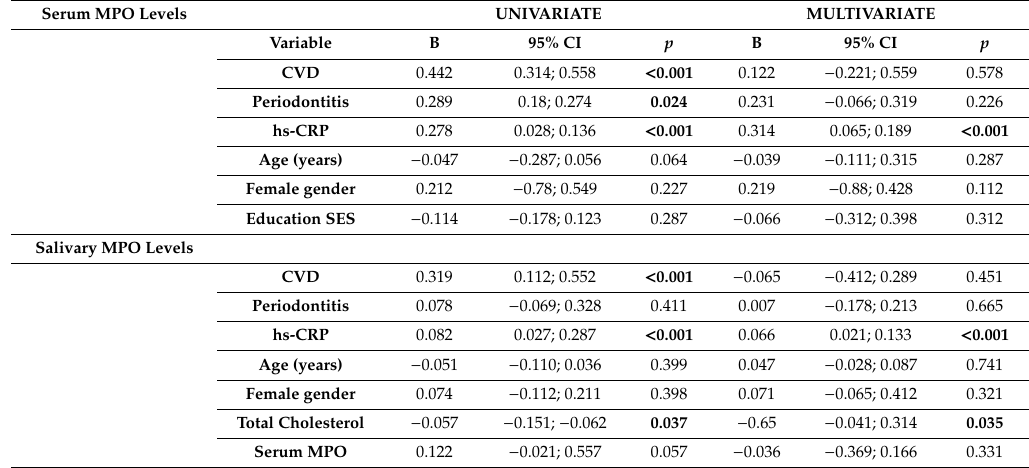
Table 3. Uni- and multivariate linear regression analysis for MPO levels in serum and saliva in all patients. Age was included as continuous variable. For periodontitis and cardiovascular disease (CVD), controls served as reference. For gender, male served as